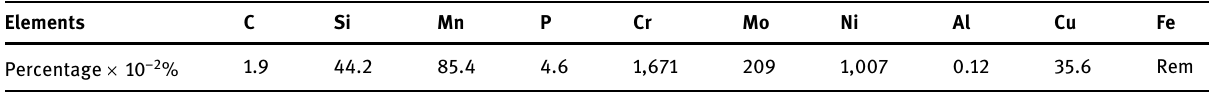
Table 1: Chemical analysis of the specimen utilized Elements C Si